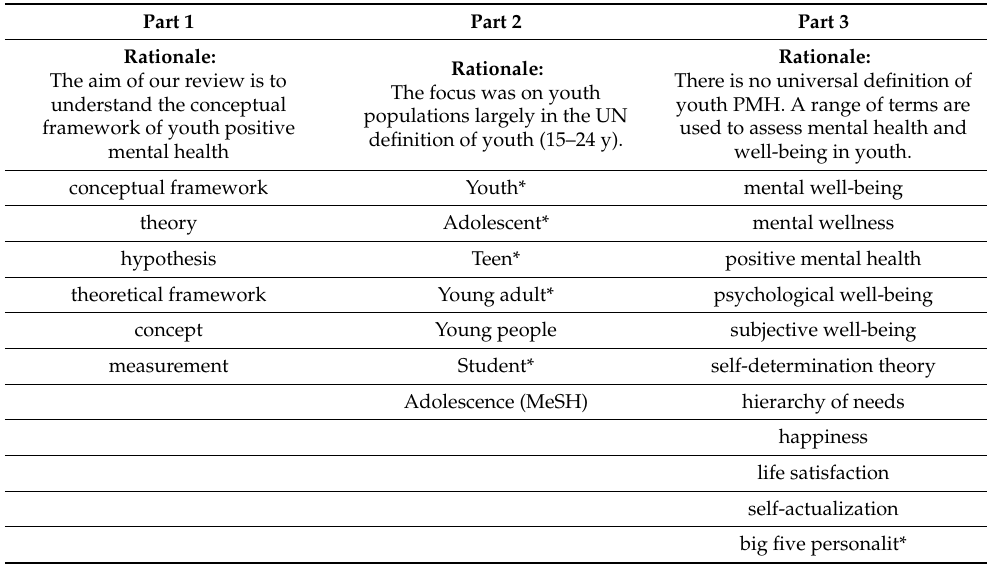
Table 1. Broad search strategy to identify articles on positive mental health (PMH) in youth. Part 1 Part 2 Part